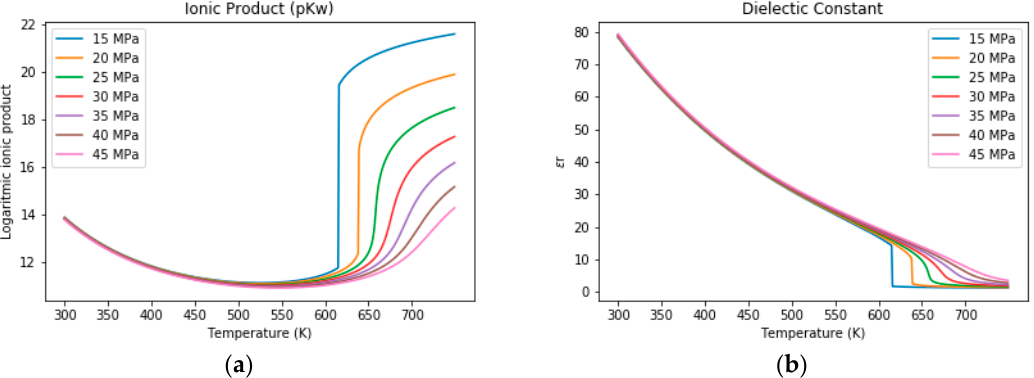
Figure 4. Logarithmic ionic product ( pK w ) and dielectric constant ( ε 0 ) of water as a function of temperature at various pressures. The data points are taken from IAPWS [63,64]: ( a ) Ionic product (pK w ); ( b ) Dielectric Constant.